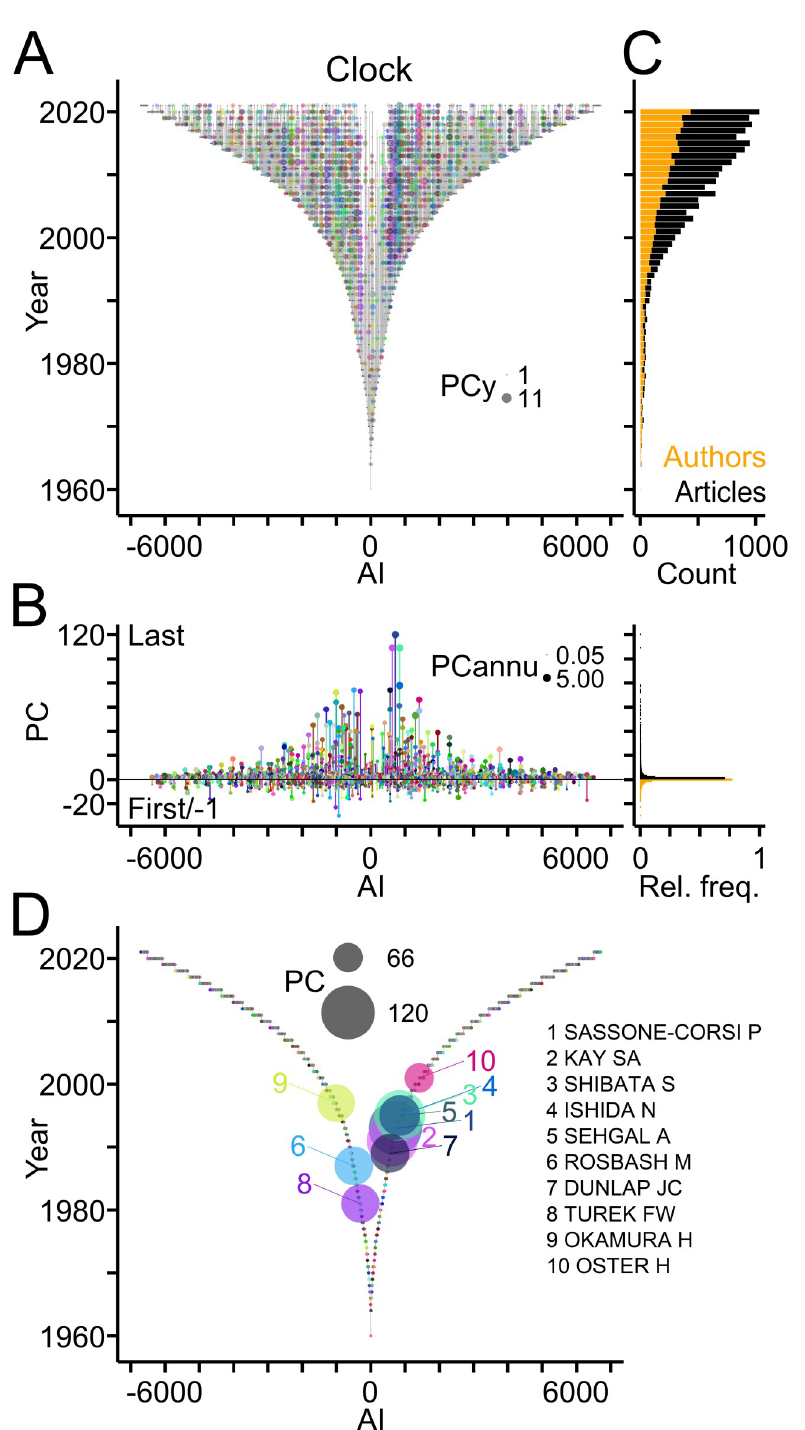
Fig 3. Publication records in the Clock field. (A) TTG showing the publication records of authors working in the Clock field. Circles connected by vertical grey lines represent for each author, the years of publications as last author plotted against the AI. Circle area indicates number of publications per author per year (PCy). (B) Left, publication count (PC) per author with numbers of last and first author articles indicated by positive and negative values, respectively. Circle area indicates the average number of publications per year (PCannu). Right, relative frequency distributions of PC values shown on the left. (C) Number of authors entering the field per year (orange) and of articles (black) published per year. (D) TTG showing authors with top ten PC values indicated by circle area.